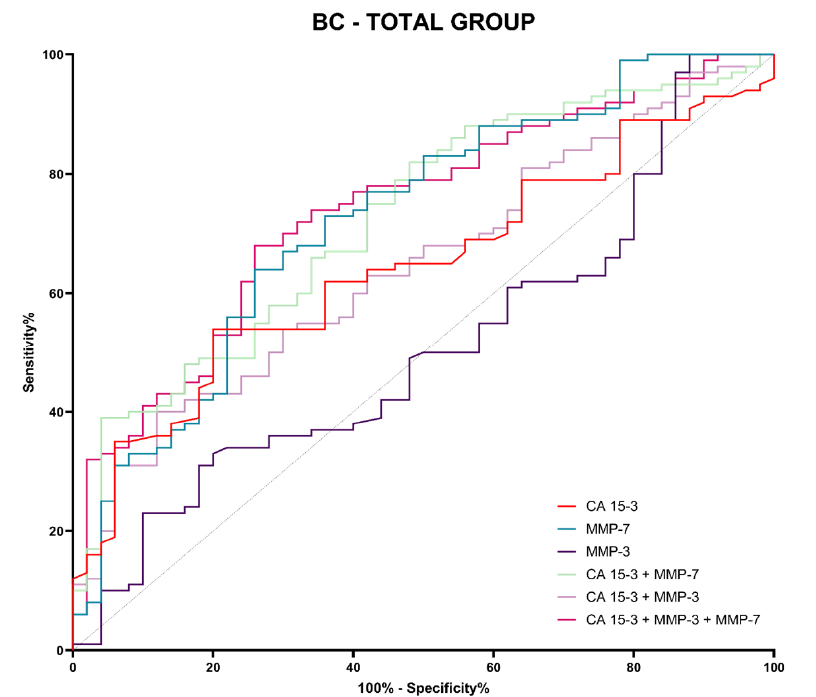
Figure 9. Evaluation of diagnostic power based on area under the ROC curve (AUC) in BC-total group.